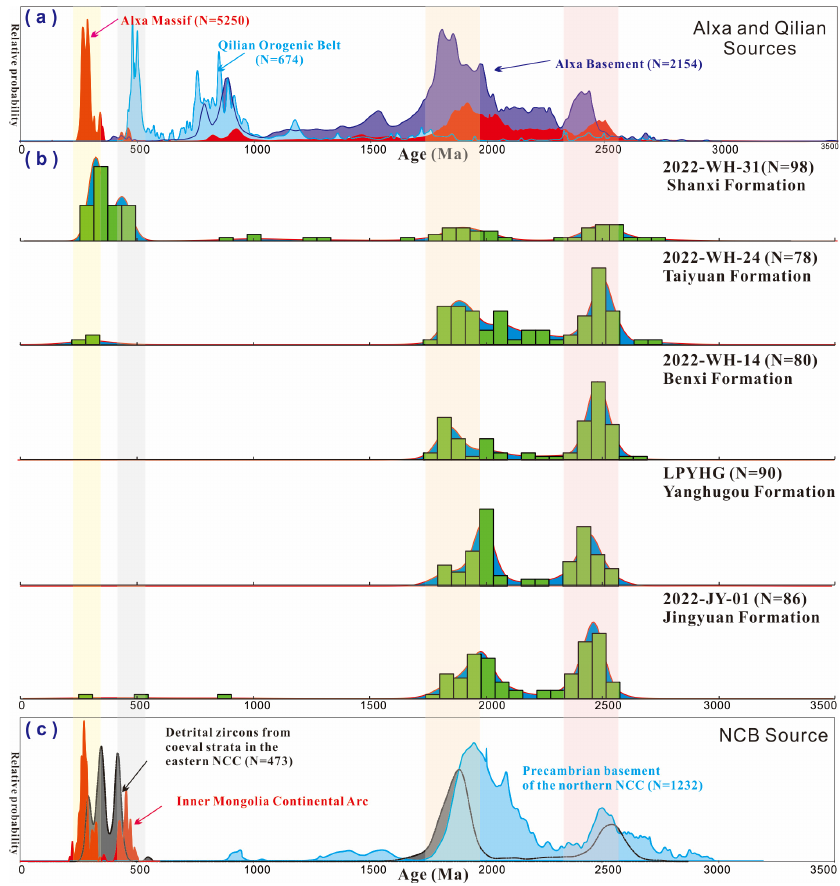
Figure 10. Probability density distribution (curves) of ages for the Alxa and Qilian sources ( a ), sandstones from Carboniferous to Permian successions ( b ) in the Wuhai Coalfield, and ( c ) the North China Block. Data for the Alxa, Qilian, and NCB basement sources are from Sun and Dong [2,17]. Sandstone modal composition data show that sources for the Carboniferous to Permian sandstones (Figure 7) are composed of various lithological blocks, showing characteristics of both stable craton and mixed orogen sources that include contributions from arc orogens and collision belts (Figure 7d). The IMCA was constructed on top of the northern NCB basement, thus, its Precambrian basement contains rocks that display bimodal early and late Paleoproterozoic signatures [32], matching well with both the NCB basement and coeval samples sourced from the IMCA (Figure 10). The younger ages, mostly in Sample 2022-WH-31 of the Shanxi Formation, with only three ages of 297 ± 6, 487 ± 10, and 863 ± 17 Ma in Sample 2022-JY-01, imply important clastic addition from arc materials. In particular, the only Neoproterozoic grain may suggest limited sediment distribution from the Bainaimiao Arc [2]. The dominant Paleozoic ages of younger zircons should be attributed to erosion of large areas of the Paleozoic plutonic bodies in the IMCA, in response to protracted south-dipping subduction of the Solonker Oceanic lithosphere [34–37].